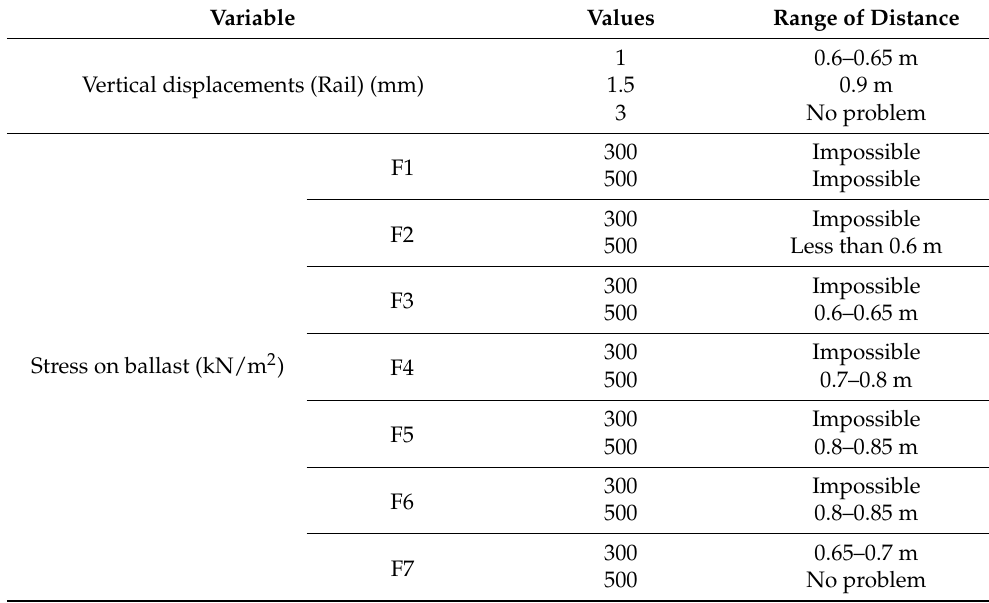
Table 9. Sleeper spacing gaps according to maximum values of most important variables in the analysis. Variable Values Range of Distance Vertical displacements (Rail) (mm)